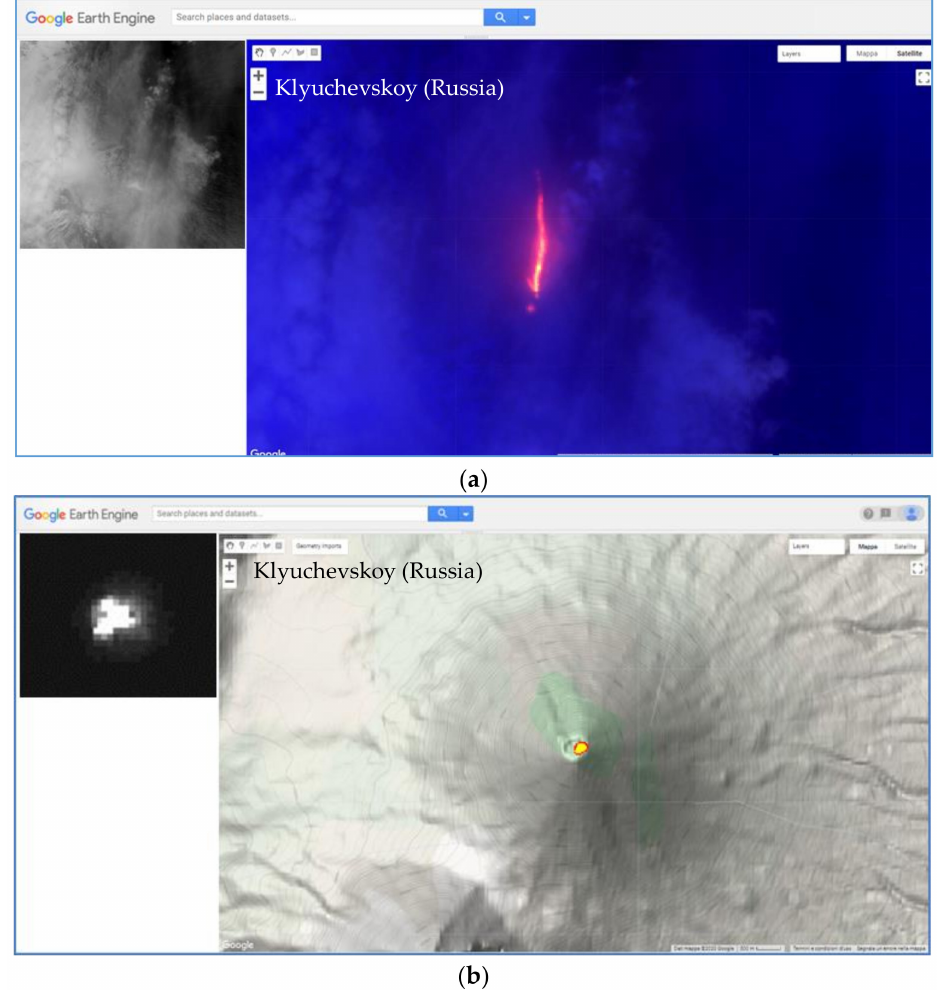
Figure 8. ( a ) RGB (Red = B05; Green = B04; Blue = B3N) map from ASTER data of 5 May 2007 at 00:32 UTC showing a lava flow at Klyuchevskoy undetected by NHI because of possible sub-pixel effects due to clouds (see visible image in the inset); ( b ) thermal anomaly of 4 April 2007 detected by NHI and unreported by the AVA database. On the top left of the maps, the ASTER (SWIR2) band 5